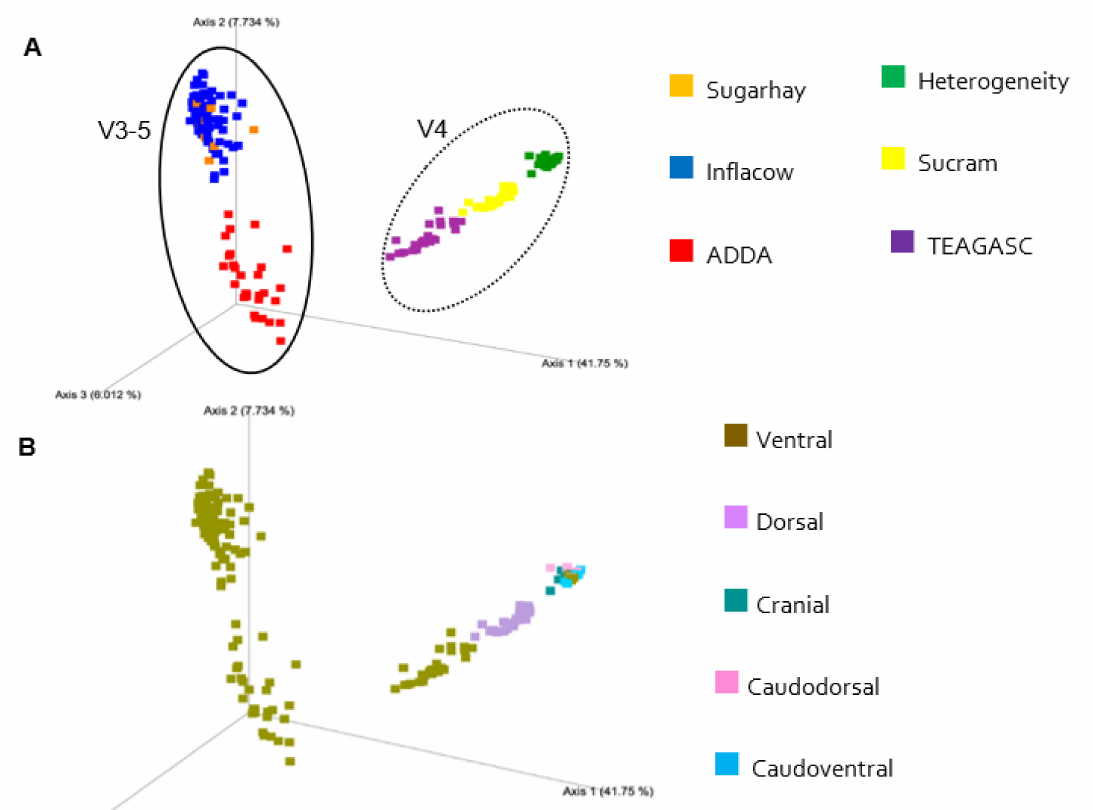
Figure 7. Principal-coordinate analysis of unweighted UniFrac distances classified by study ( A , B ) biopsy location. The amount of variation explained by the principal coordinates is given in the axes